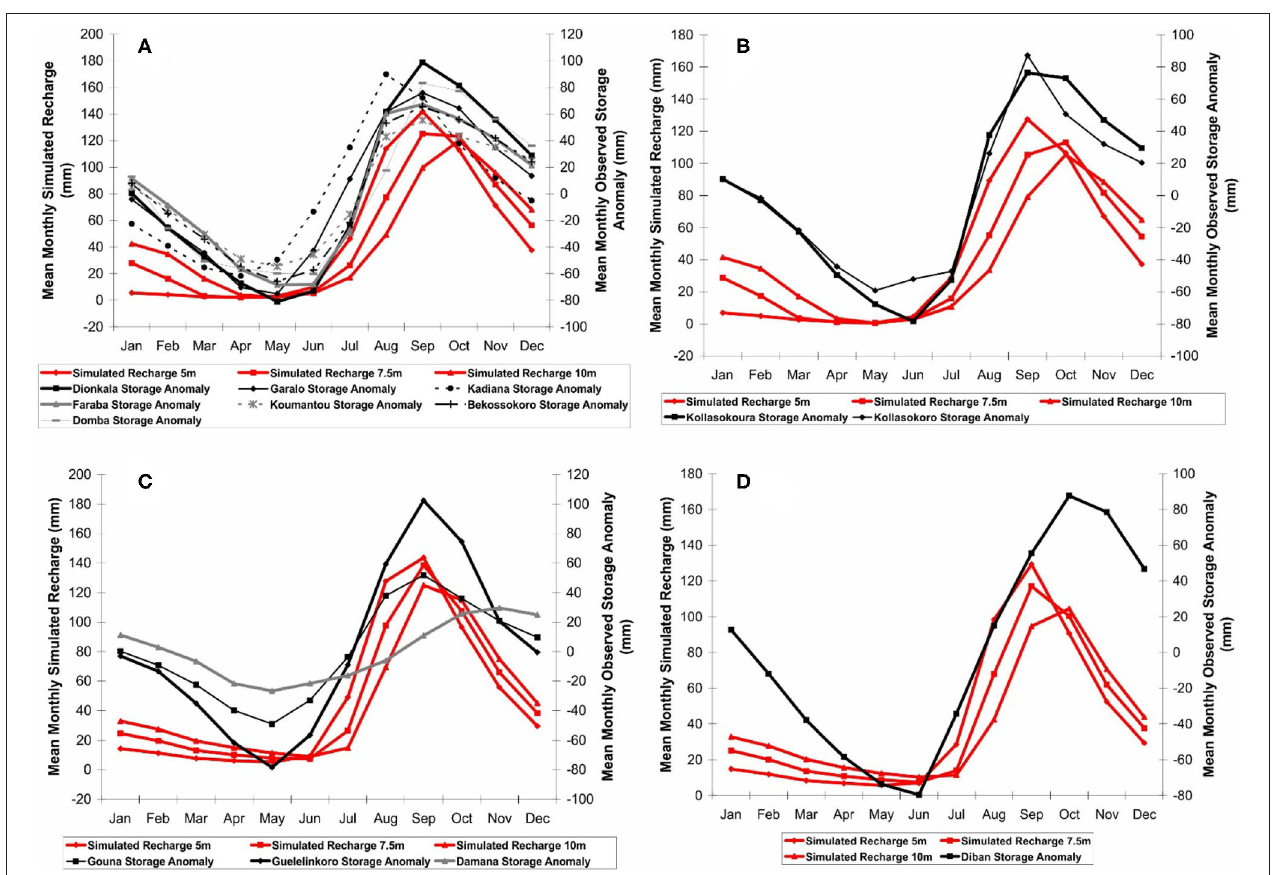
FIGURE 10 | Mean monthly simulated recharge (left y-axis) and mean monthly storage anomalies (right y-axis) for observation wells characteristic of (A) Group 1, (B) Group 2, (C) Group 3, and (D) Group 4.